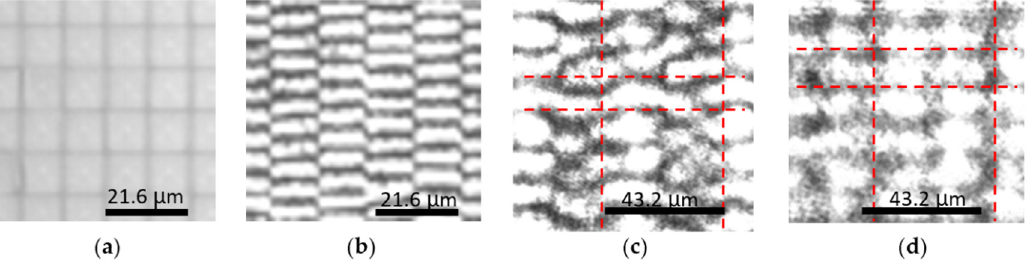
Figure 2. ( a ) Optical microscope image of PLM mirror array; ( b ) Linnik interferometric image of the PLM mirror array, with binary π /2 phase modulated CGH with 2 pixels/period; ( c ) doubly modulated binary π /2 CGH with 4 pixels/period. The half fringe shift within a single period shows phase is modulated by π ; ( d ) the doubly modulated π -phase-shifted pattern shows a continuous fringe over pixels that shows that a 2 π phase modulation is achieved. For ( a – c ), the PLM is illuminated by a collimated 532 nm beam.